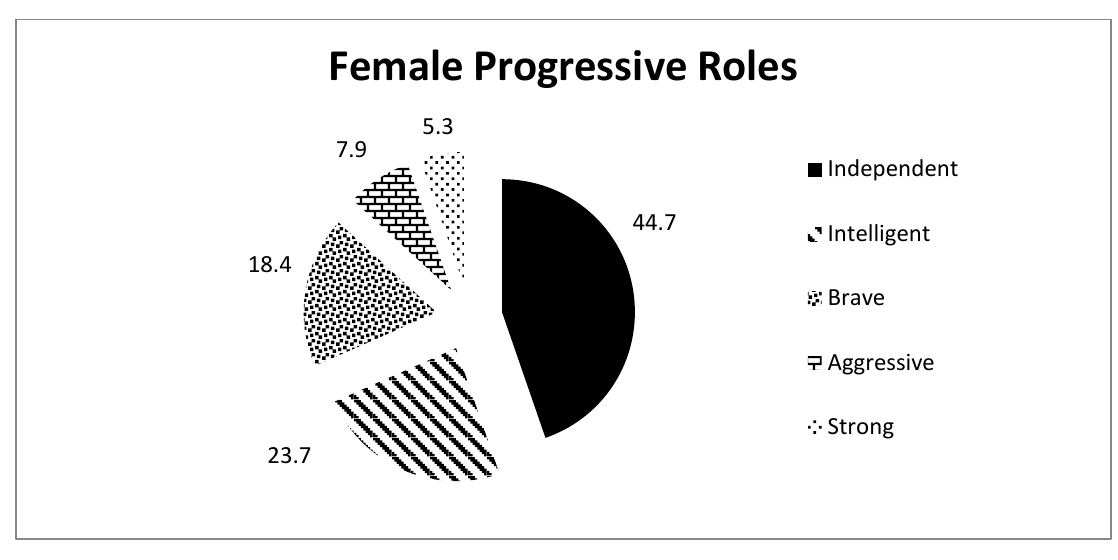
Female progressive roles. Independence is by far the most highly exhibited role.